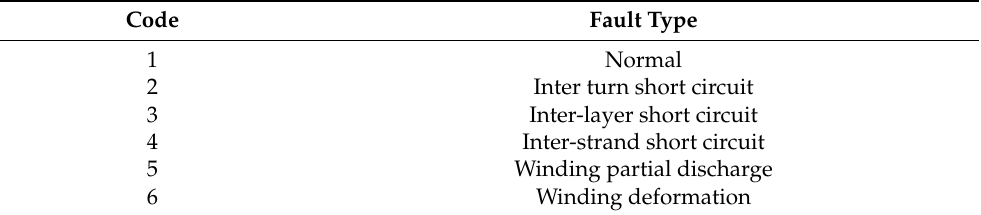
Table 5. Fault classification